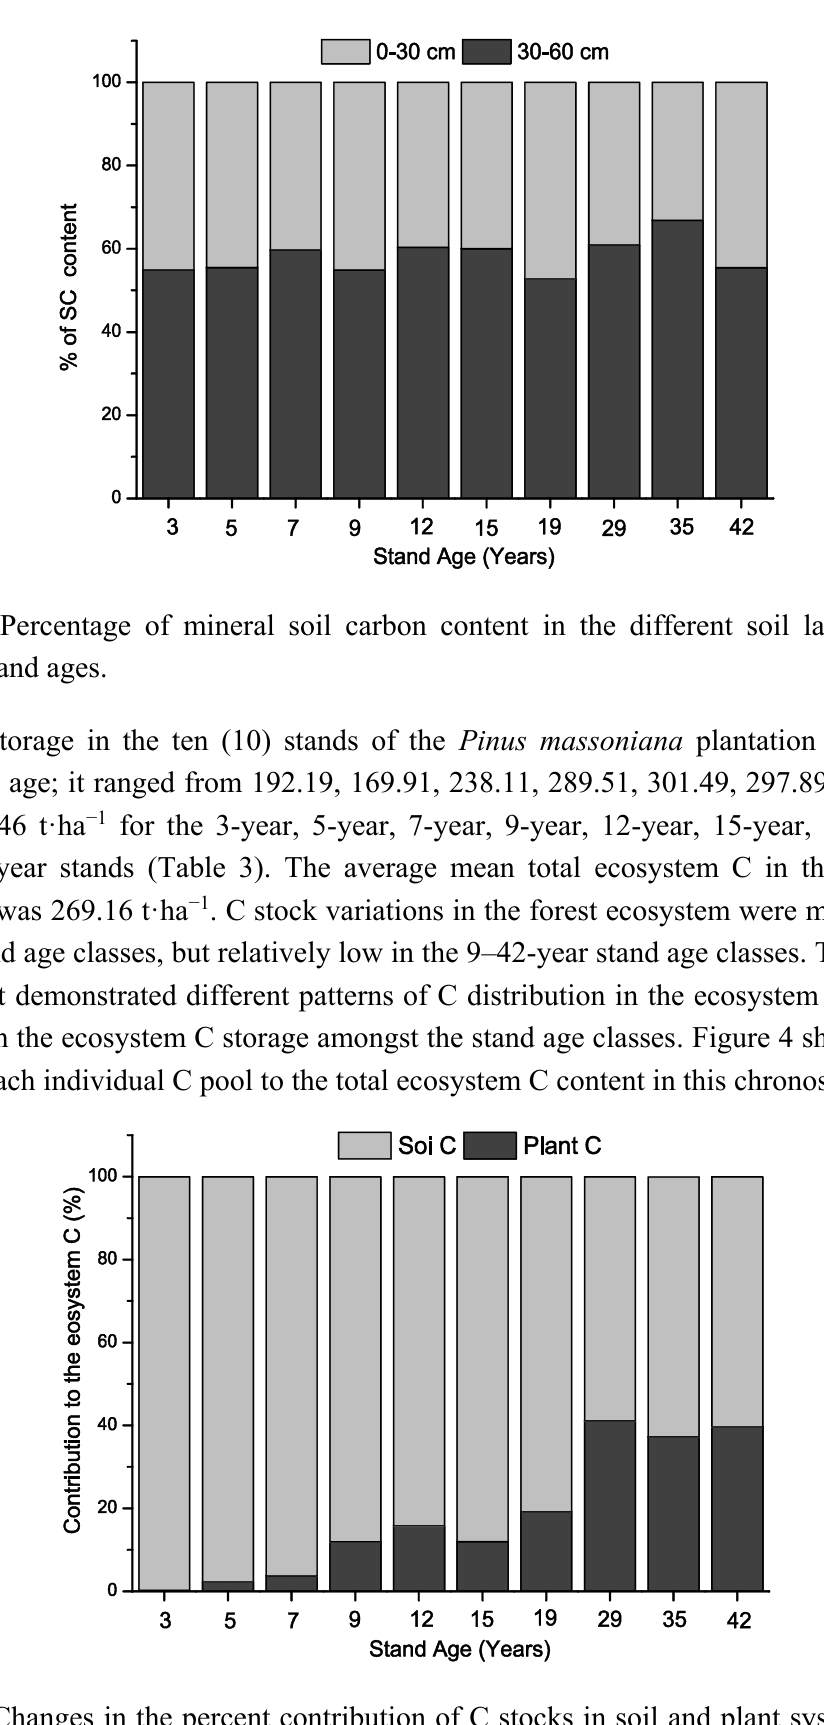
Figure 4. Changes in the percent contribution of C stocks in soil and plant systems to the Pinus massoniana plantation ecosystem with stand age in Gao County, Sichuan